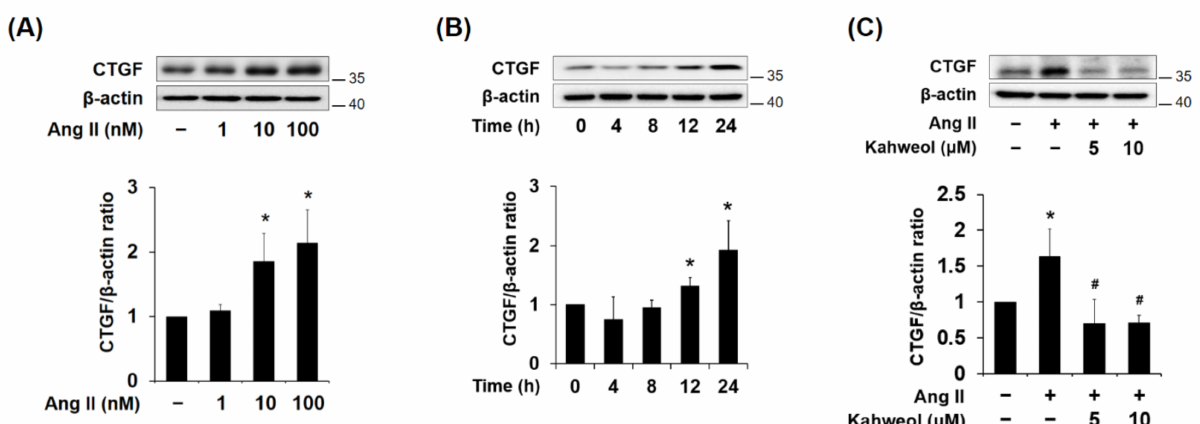
Figure 1. Effect of kahweol on connective tissue growth factor (CTGF) protein expression in Ang II-stimulated vascular smooth muscle cells (VSMCs). ( A , B ) Western blot analysis of CTGF in Ang II-treated VSMCs. Cells were exposed to various concentrations of Ang II (0, 1, 10, and 100 nM) for 24 h. In addition, cells were treated with Ang II 100 nM for the indicated times (0, 4, 8, 12, and 24 h). Protein samples were refined from cultured VSMCs treated with Ang II. ( C ) Cells were pretreated in the presence or absence of kahweol (0, 5, and 10 µ M) for one hour, and then stimulated with 100 nM Ang II for a further 24 h. Protein levels of CTGF and β -actin were determined by Western blotting with specific antibodies. Bar graphs present the densitometric quantification of the Western blot bands. Results are representative of three independent experiments. *, p < 0.05 vs. untreated control; #, p < 0.05 vs. Ang II